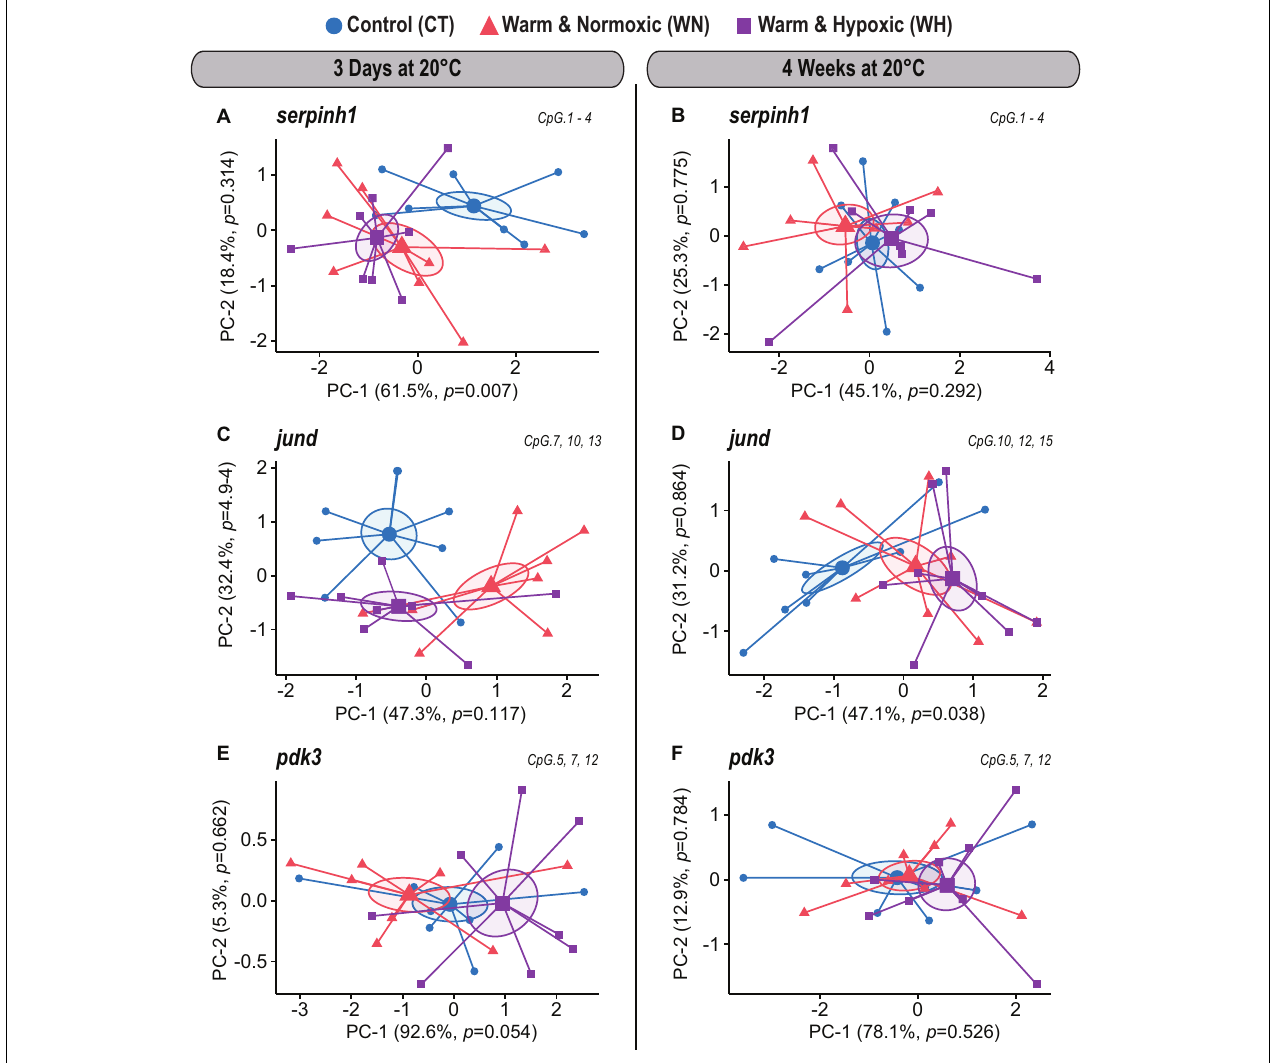
FIGURE 3 | DNA methylation dynamics of responsive CpGs in three genes up-regulated in Atlantic salmon exposed to high temperature and hypoxia. Principal Component Analysis (PCA) on DNA methylation percentages (%) for treatment responsive CpGs from three up-regulated target genes ( serpinh1 , jund , and pdk3 ) measured in the liver of Atlantic salmon exposed to high temperature alone (WN: 20 ◦ C, ∼ 100% air saturation) or combined with hypoxia (WH: 20 ◦ C, ∼ 70% air sat.) for 3 days or 4 weeks, as compared to control conditions (CT: 12 ◦ C, ∼ 100% air sat.) ( n = 8 per treatment/time point, N = 48 total). PCAs are illustrated separately for each up-regulated gene and exposure time point [ serpinh1 (A,B) ; jund (C,D) , pdk3 (E,F) ]. PCAs show cluster distribution between the CT, WN, and WH groups with ellipses demonstrating the dispersion of variance and enlarged symbols indicating the center of the distribution for each group. The variance explained by PC-1